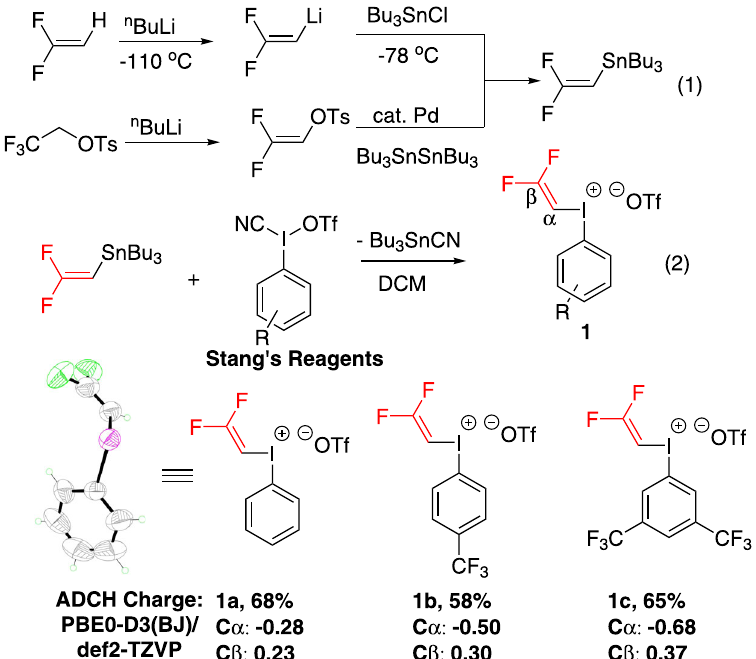
Fig. 3 The synthesis and ADCH charge of gem-di fl uorovinyl iodonium reagents (DFVI) 1. X-ray structure of 1a (CCDC No.: 2141360). The counter anion is omitted for